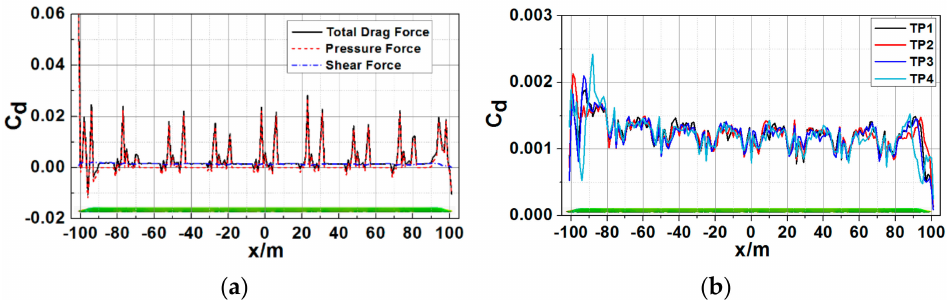
Figure 10. Plots of pressure drag and shear force drag: ( a ) plots of drag on TP1 at t = 2 s; ( b ) distribu- tions of shear force coefficients of four models along the train